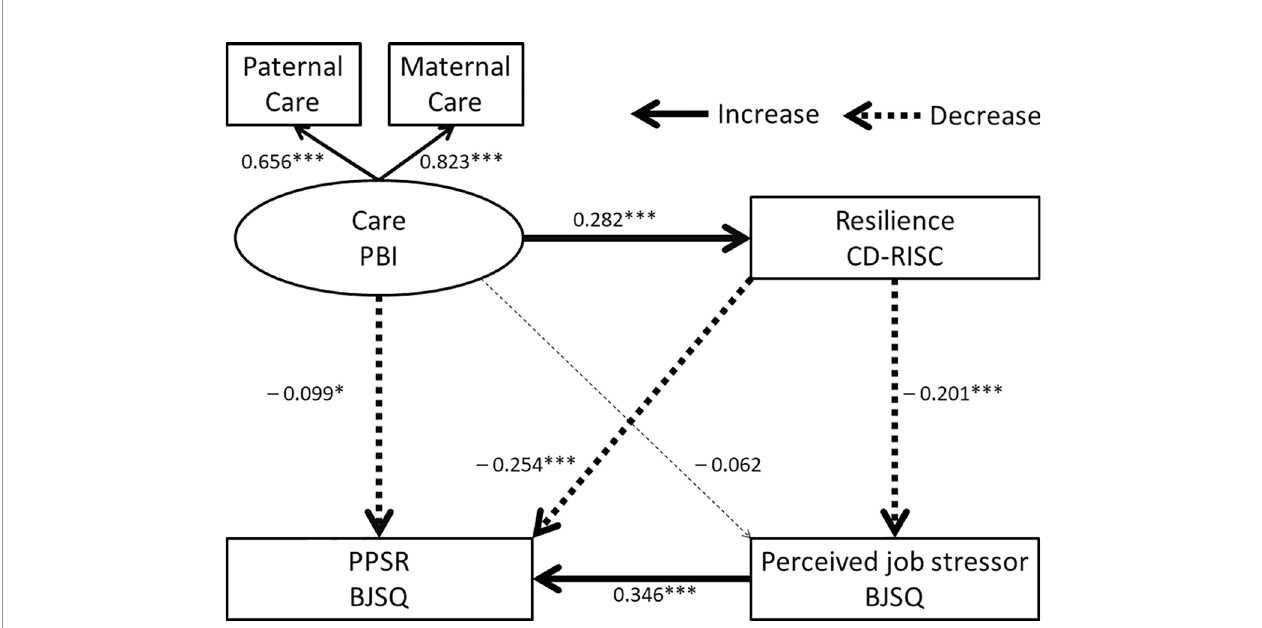
FIGURE 1 | Structural equation model of parental care (PBI), resilience (CD-RISC), perceived job stressors (BJSQ), and PPSR (BJSQ). Solid arrows indicate increased effects, dotted arrows indicate decreased effects, and a thin dotted line indicates a nonsigni fi cant effect. Coef fi cients beside the lines are standardized. The latent variable “ care ” consists of paternal and maternal care. *p < 0.05, ***p <